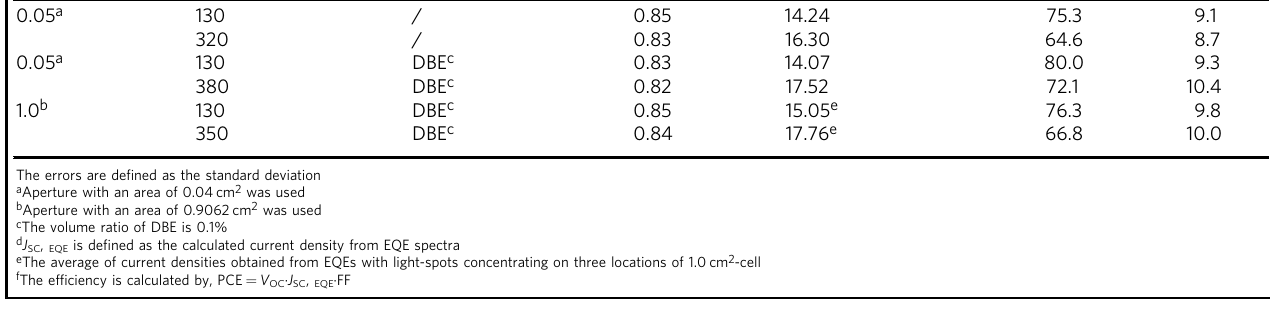
Table 1 Photovoltaic parameters for all-PSCs based on PBTA-Si:PTzBI-Si:N2200 (1.3:0.7:1) Area (cm 2